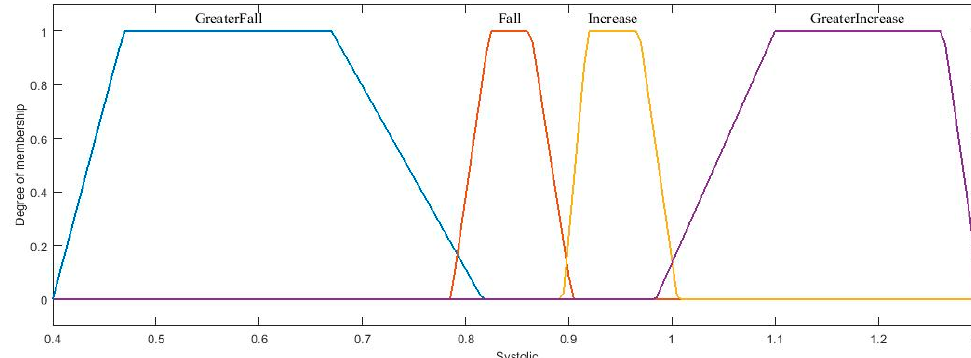
Figure 19. Optimized diastolic quotient input.